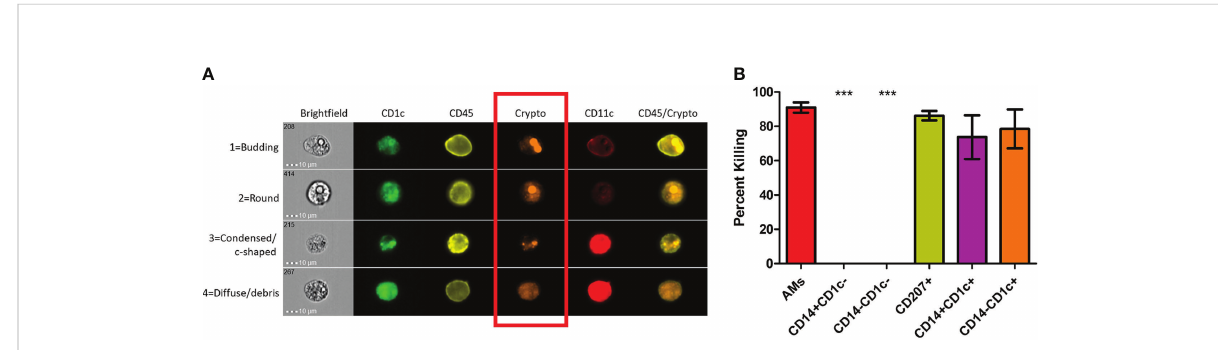
FIGURE 2 Subsets of Phagocytic APCs Show Differential Killing of C neoformans . Processed human BAL cells were enriched for phagocytic APCs and incubated with fl uorescent mCherry expressing C neoformans strain JLCN920 for 2h and then stained with fl uorescent antibodies for imaging fl ow cytometric analysis. (A) Representative images of internalized C neoformans to determine fate of the fungus. Budding and round fungal cells were considered as living while condensed and debris were deemed at dead cells (red box). (B) Percent killing of C neoformans by phagocytic APC subsets. Up to 100 images of internalized cryptococcal cells by each subset were analyzed according to panel (A) . 4 of the 6 subsets showed substantial killing (>70%) of internalized fungal cells. Macrophage subsets CD14 + CD1c - and CD14 - CD1c - allowed live fungal cells to persist internally in all analyzed images. Data shown are means ± standard errors of the means (SEM) of the results of 2 independent experiments using 12 independent BAL samples (n=12). One-way ANOVA with Tukey ’ s Multiple Comparison Test was performed to compare each column against all others. *** indicates signi fi cantly different means from killing subsets ( p <